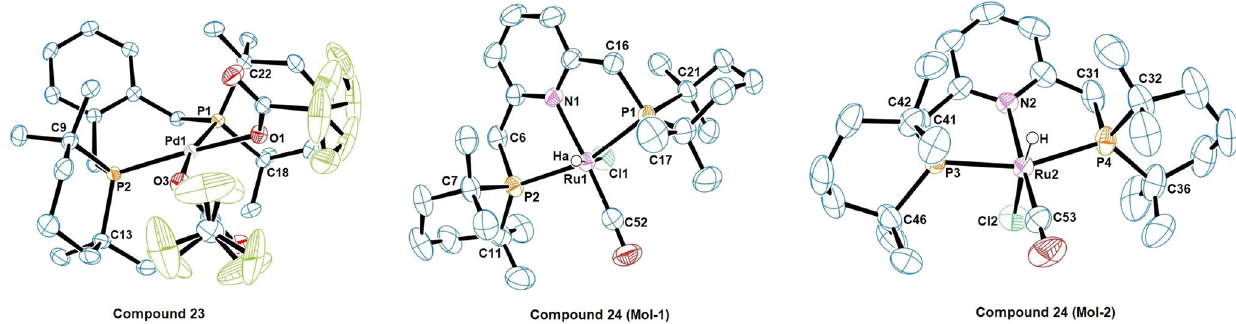
Fig. 8 Molecular structures of TMPhos-containing metal complexes. ORTEP representations for the crystal structures of [(BTMPX)Pd(O 2 CCF 3 ) 2 ] 23 and [ TMPhos (PNP)Ru(CO)(Cl)H] 24 , drawn at 50% probability. The fl uorine atoms of the CF 3 groups exhibit rotational disorder in the crystal